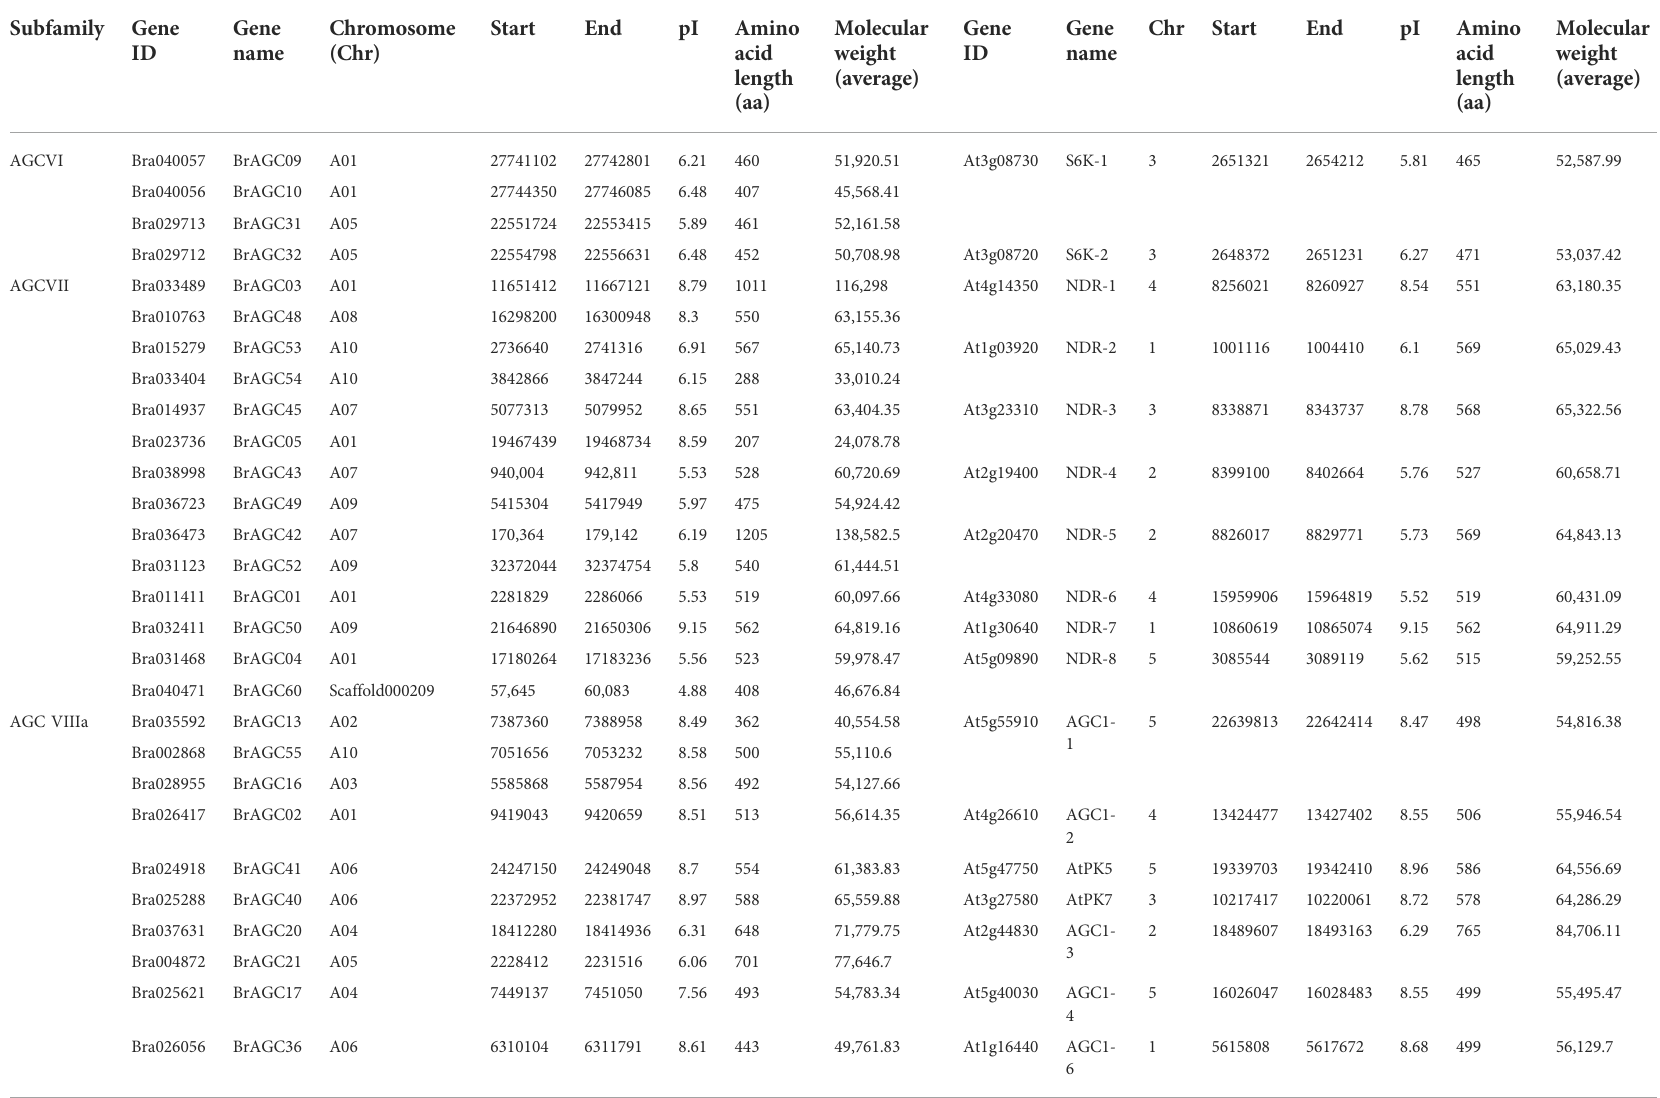
TABLE 1 Basic information of AGC genes identi fi ed in B. rapa and A. thaliana